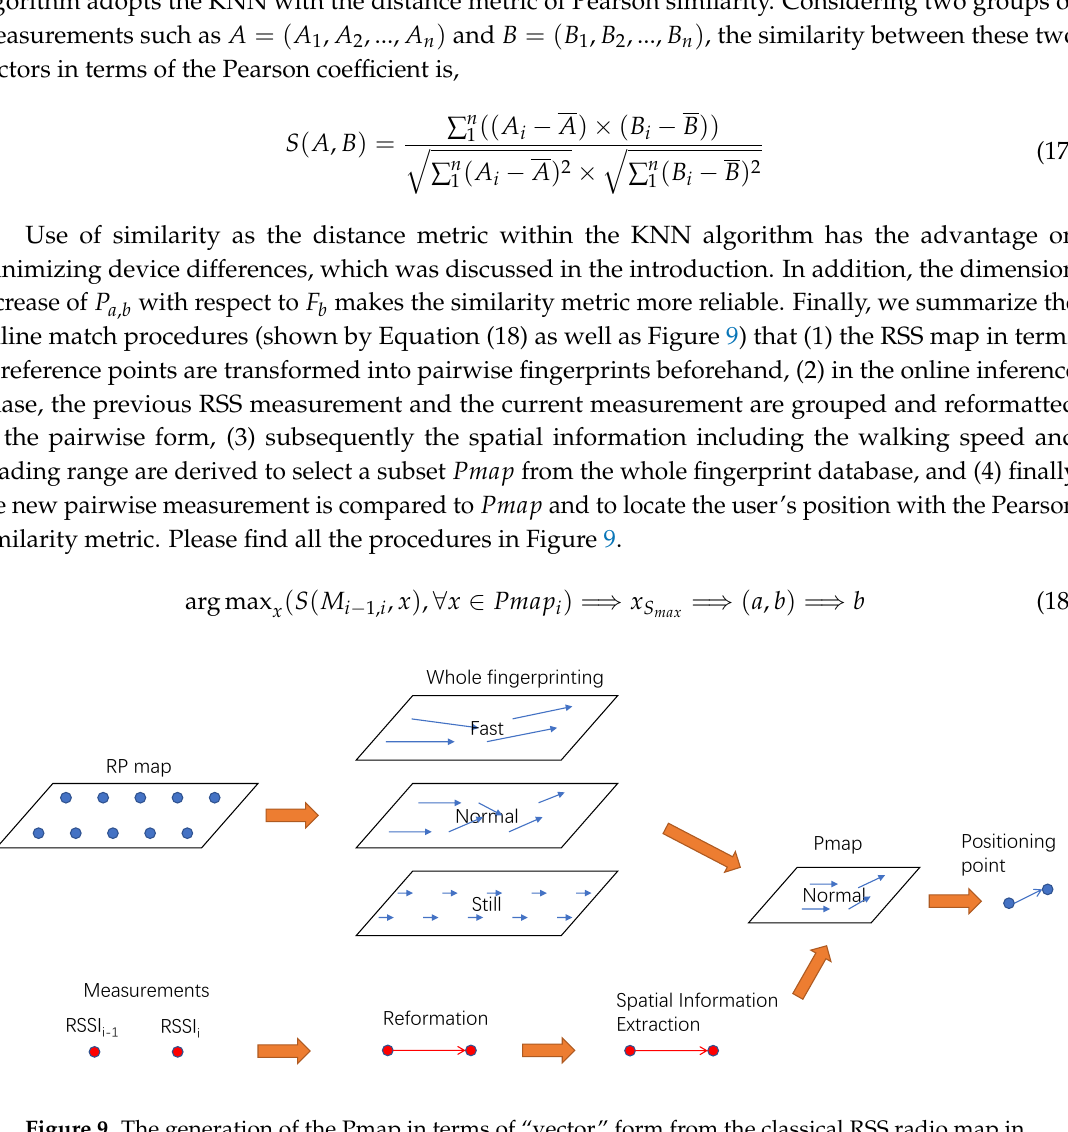
Figure 9. The generation of the Pmap in terms of “vector” form from the classical RSS radio map in terms of the reference point (RP), and the online inference procedure with the Pmap and the reformatted measurements leveraging real-time mobility